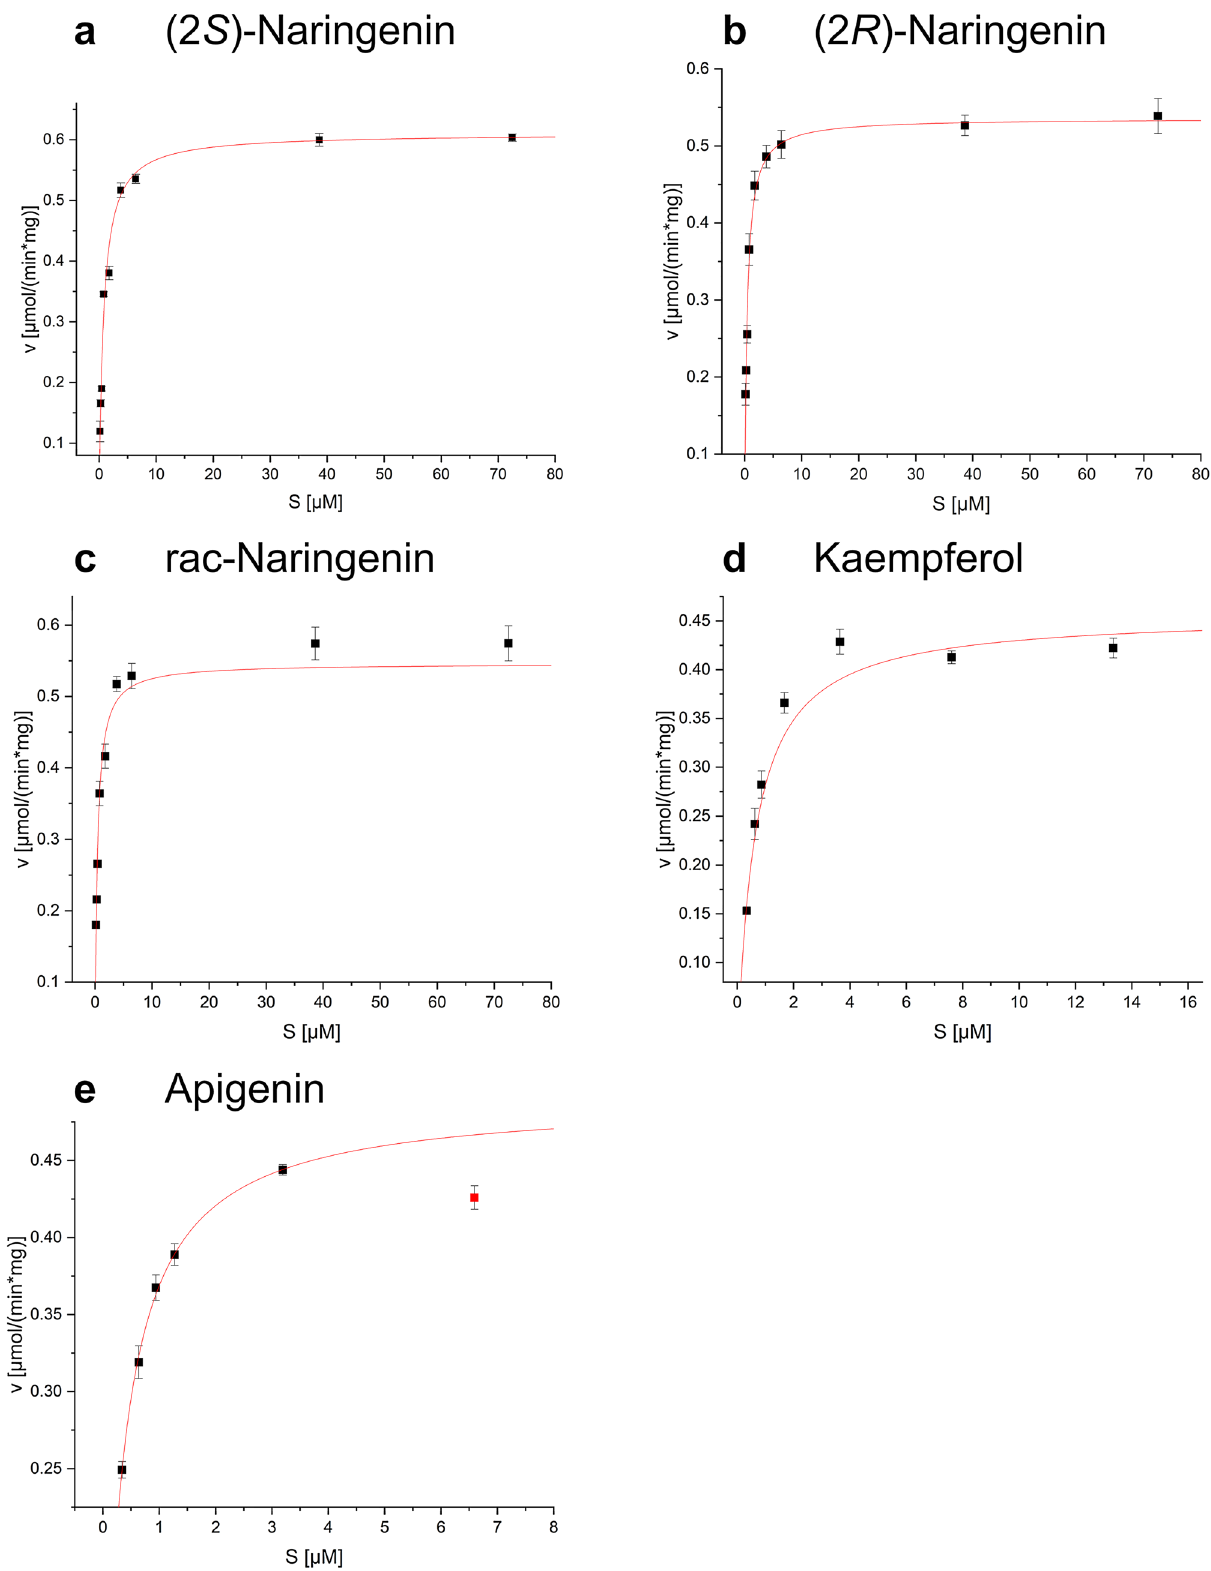
Figure 6. Specific activity (v) of the recombinant membrane bound Dv CH3H in dependence of the substrate concentration (S). The graphs show steady state kinetic measurements of Dv CH3H using ( a ) (2 S )-naringenin, ( b ) (2 R )-naringenin, ( c ) racemic naringenin, ( d ) kaempferol and ( e ) apigenin as